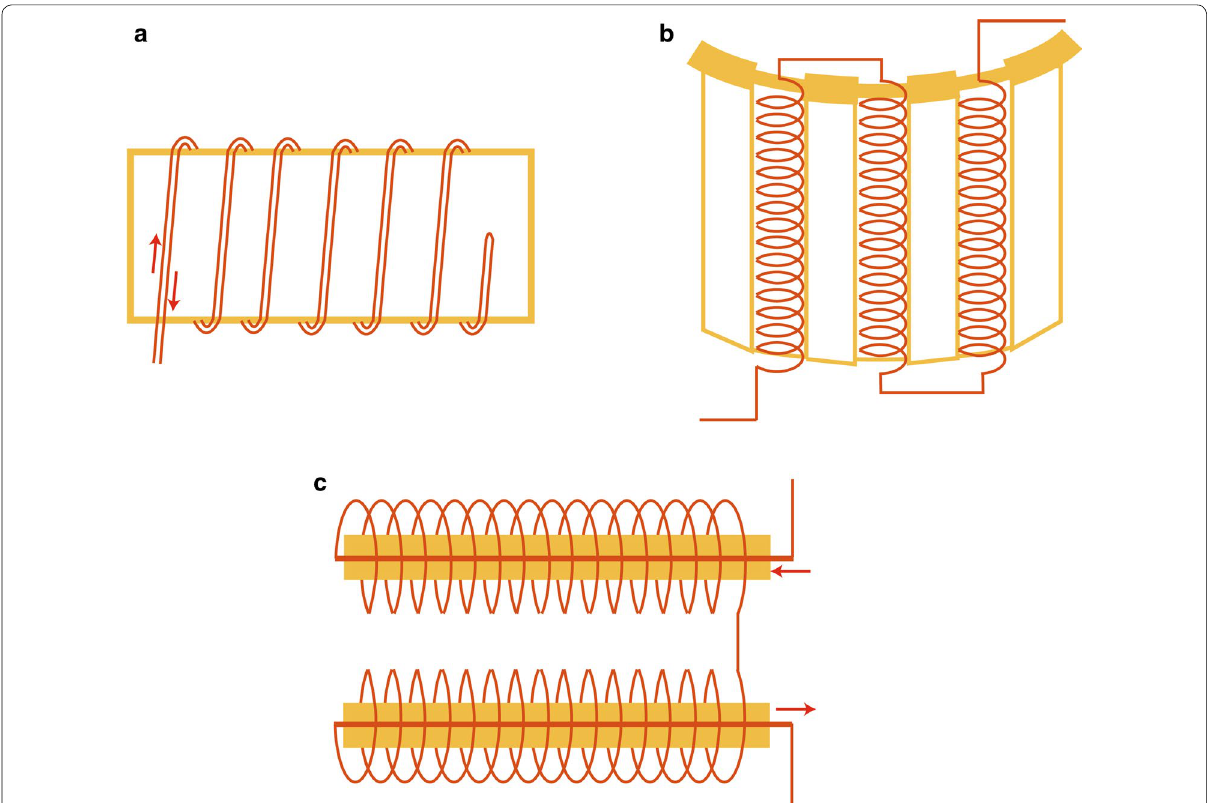
Fig. 1 Configuration of non-inductive heating wires. a Bifilar solenoid wrapped for a small oven, b solenoid-like helical heating wires arranged in a larger oven, c the new straight core solenoid heating wires using in the TD-PGL-100. Arrows indicate the current flow